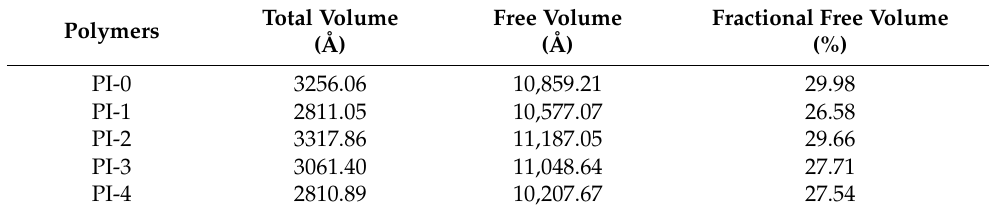
Figure 4. Molecular dynamic simulations of the molecular cells of the PIs. Table 3. FFV of the PIs.